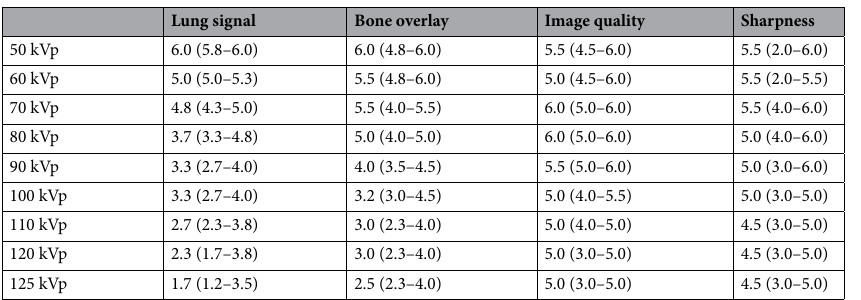
Table 1. Results of the reader study examining the dark-field images. All values are given in median (range) of the three readers after calculation the mean of their readings. The highest mean for both image quality and sharpness was found for 70 kVp. The lowest bone overlay (i.e. the highest dark-field signal despite the opacity) was found for the lowest tube voltages, going along with the very high dark-field signal strength at these